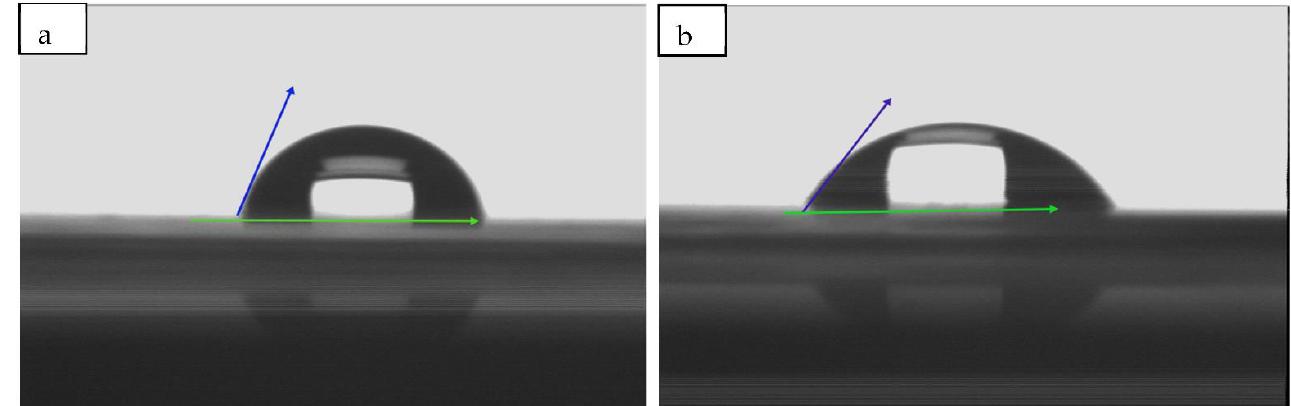
Figure 2. Contact angle measurements of polymeric nanoparticle uncoated ( a ) and coated QCM surfaces ( b ).